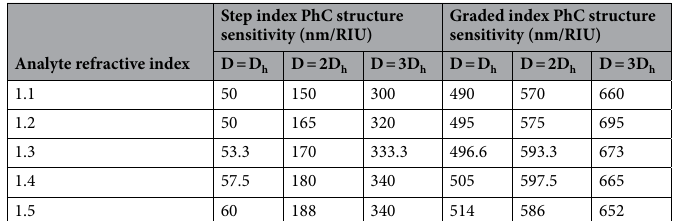
Analyte refractive index